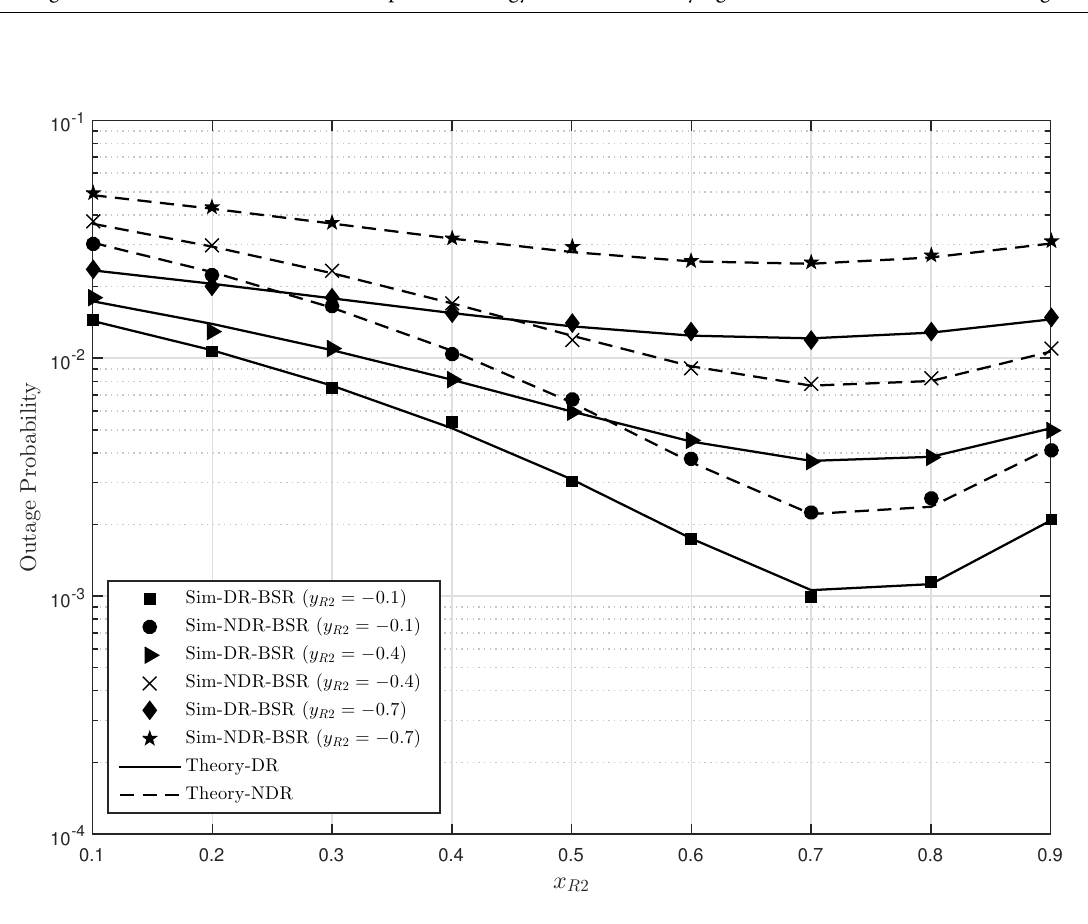
of -0.1, -0.4, and -0.7 with R 2